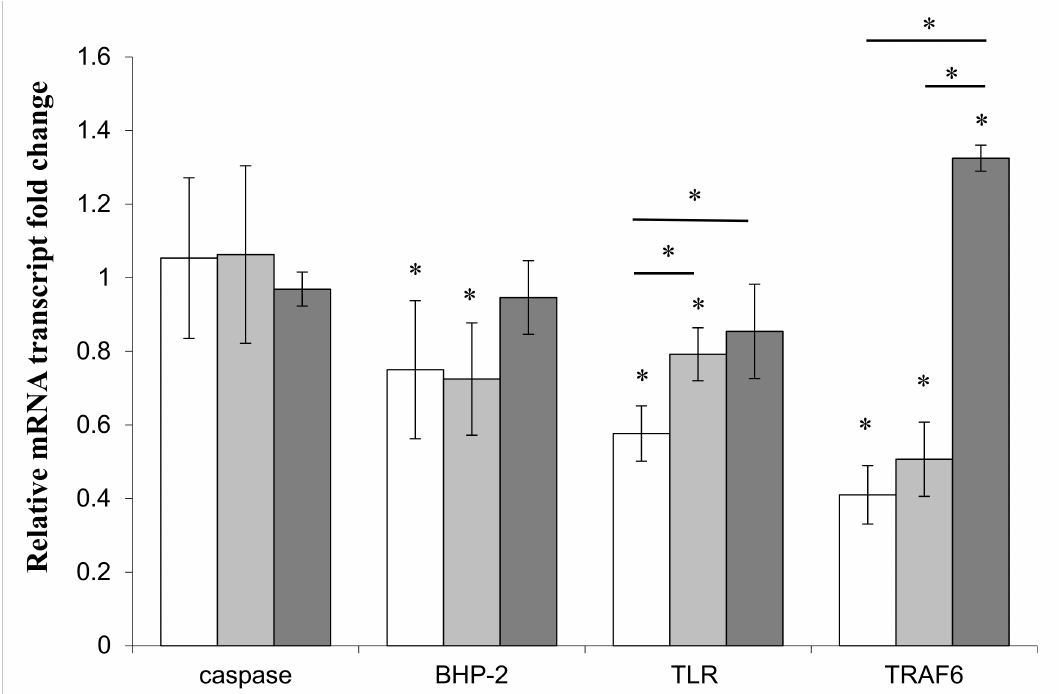
Figure 4. Expression of genes related to the immune system (Toll-like receptor (TLR) and TRAF-6) and to the apoptotic pathway (caspase and BCl 2 -homolog protein (BHP-2)) in primmorphs co-incubated in the presence of 2mg / mL of lipopolysaccharides of respectively the sponge-isolated bacterium Endozoicomonas sp. Hex311 ( ) or Pseudoalteromonas sp. 1A1 ( ) and the control bacterium Escherichia coli ( ). (*) Statistical di ff erences between the standard and the stimulated condition a materialized by an asterisk and statistical di ff erences between primmorphs stimulated by the two bacteria are materialized by a horizontal